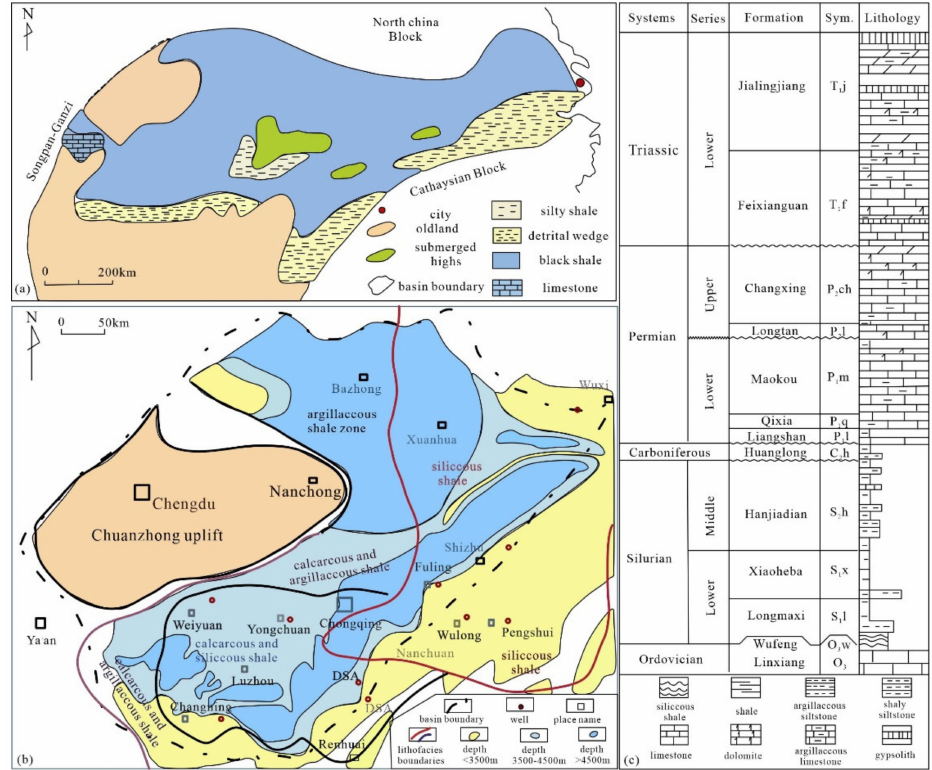
Figure 1. The location of Sichuan Basin ( a ), the Dingshan area (DSA) ( b ), and the geological column of Sichuan Basin ( c ) (modified from Wang et al.